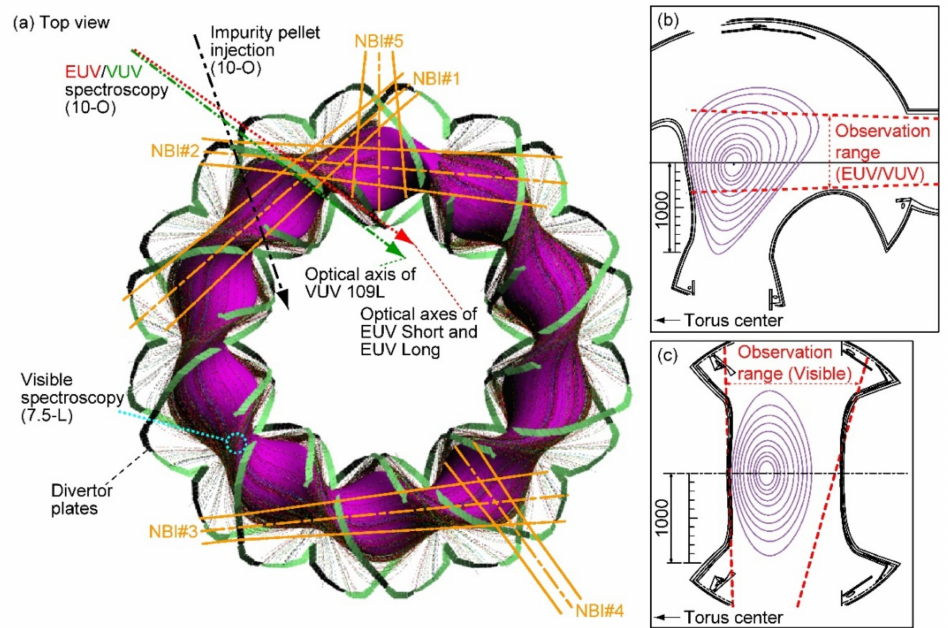
Figure 1. ( a ) Top view of shape of plasma in LHD device together with schematic drawings of neutral beam injection (NBI) for heating, spectroscopic diagnostics, and impurity pellet injection. Cross sections of magnetic surfaces where optical axes of ( b ) VUV/EUV and ( c ) visible spectroscopy systems are located, respectively, together with viewing angle of each